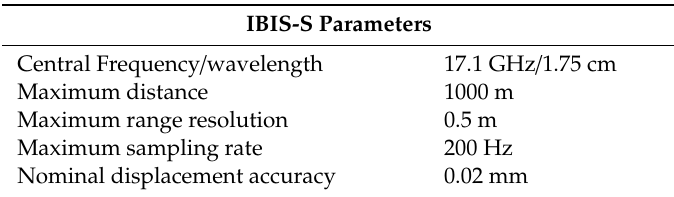
Table 1. Main characteristics of the IBIS-S system.